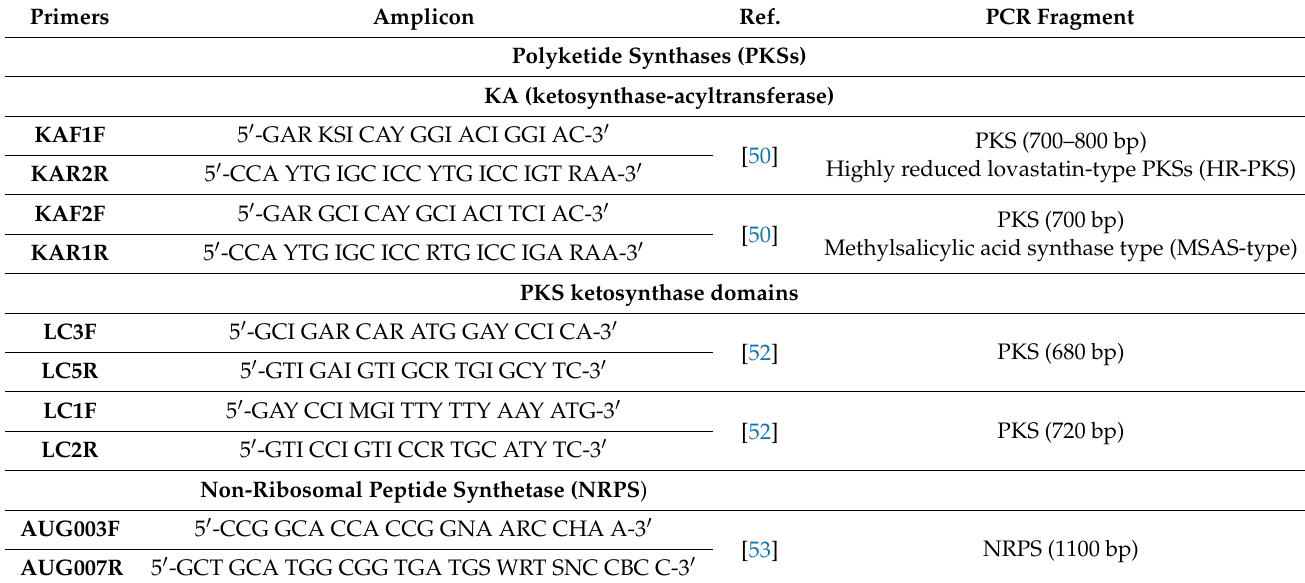
Table 4. Sets of degenerate primers for PKSs and NRPS detection in Penicillium sp. Degenerated nucleotides following the International Union of Pure and Applied Chemistry (IUPAC) nucleotide code are